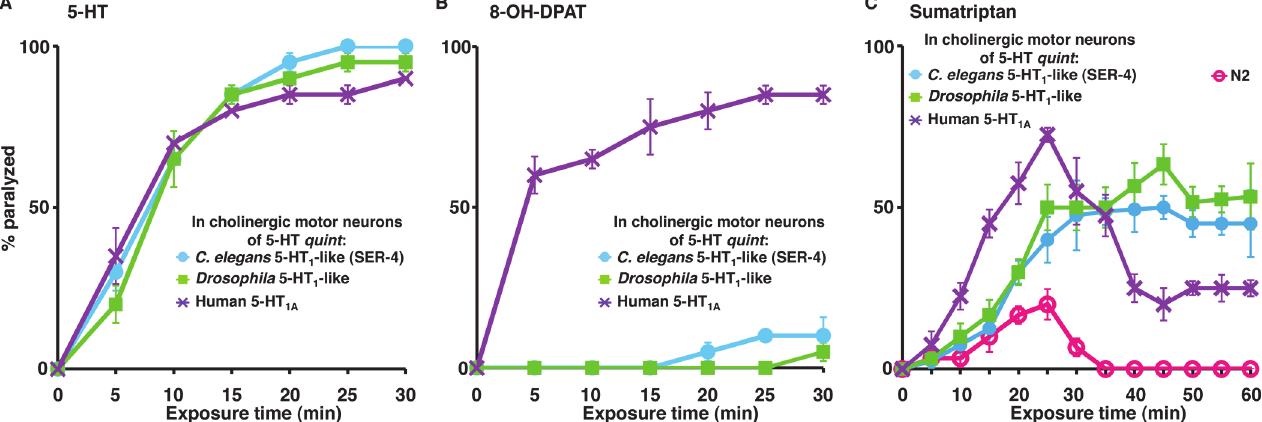
Fig 3. 5-HT and 5-HT receptor agonists selectively paralyze C . elegans 5-HT receptor mutant animals expressing nematode, insect or human 5-HT 1 -like receptors in the cholinergic motor neurons. A-C. Paralysis of wild type, mutant and transgenic C . elegans on hypotonic, non-NGM agar plates. A. 5-HT (1 mM)-dependent paralysis of 5-HT quint animals expressing either C . elegans 5-HT 1 -like (SER-4), Drosophila 5-HT 1 -like, or human 5-HT 1A receptor in cholinergic motor neurons (P unc-17 β ). Data are presented as mean ± SE (n = 3). B. 8-OH-DPAT (2 mM)-dependent paralysis of 5-HT quint animals expressing either C . elegans 5-HT 1 -like (SER-4), Drosophila 5-HT 1 -like, or human 5-HT 1A receptor in cholinergic motor neurons (P unc-17 β ). Data are presented as mean ± SE (n = 3). C. Sumatriptan (1 mM)-dependent paralysis of wild type, 5-HT quint animals expressing either C . elegans 5-HT 1 -like (SER-4), Drosophila